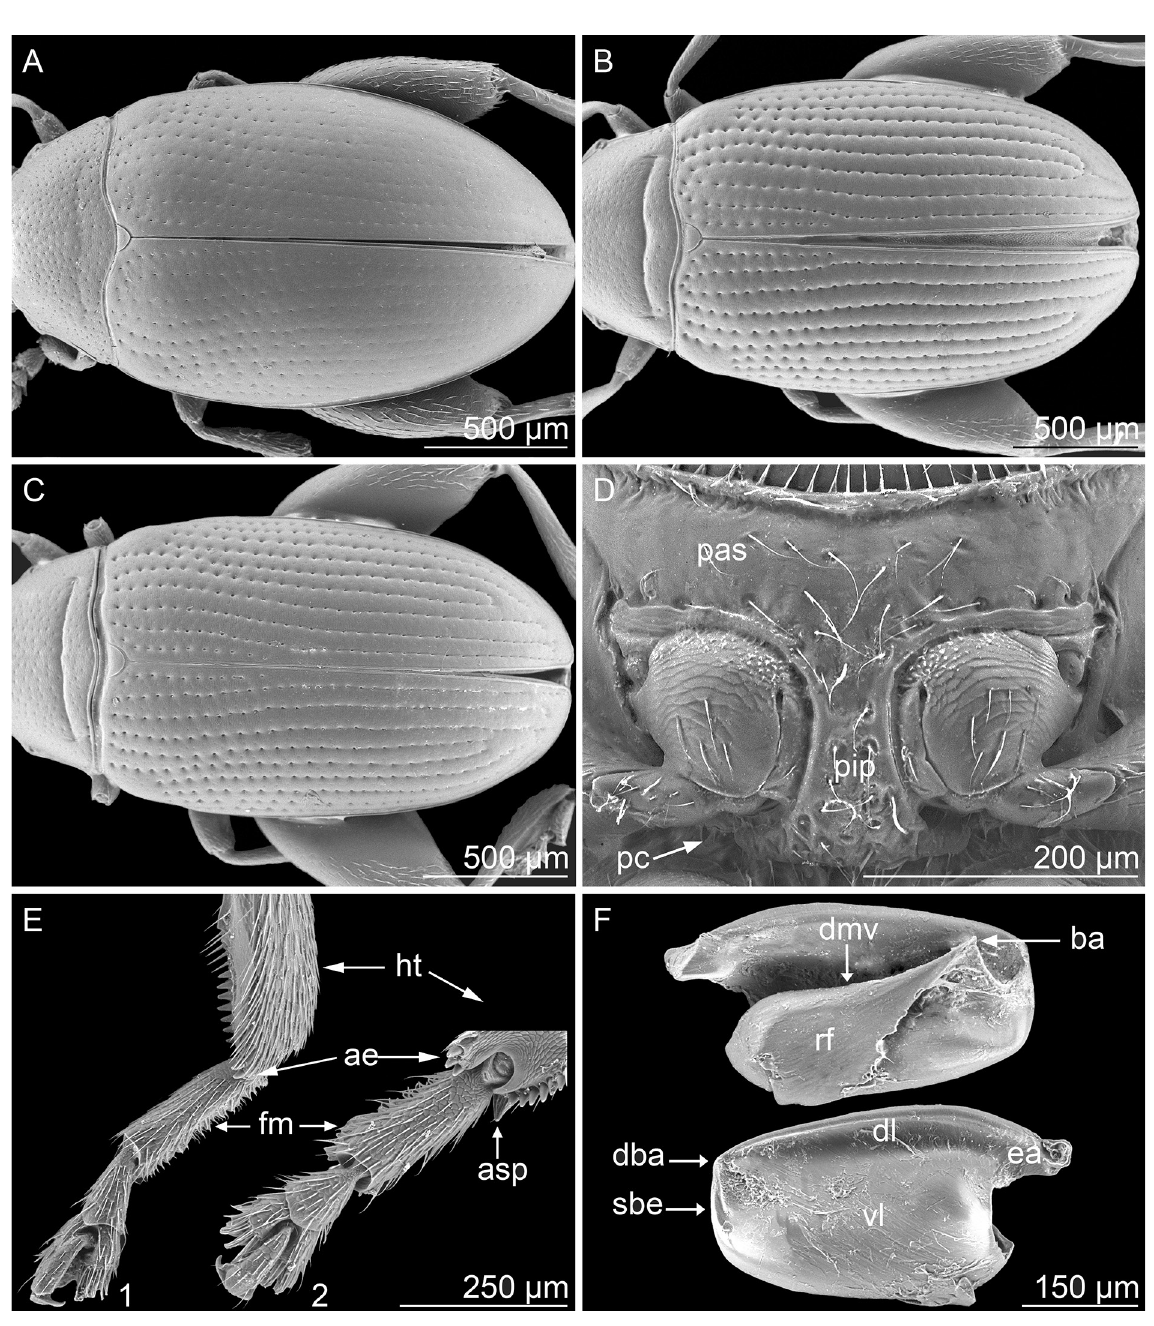
Fig. 6. A–C . Elytra. A . Arsipoda atra sp. nov., Aoupinié. B . A. geographica Gómez-Zurita, 2010, Dzumac Mts (base). C . A. shirleyae Samuelson, 1973, Chute de la Madeleine. D . Prosternum of A. punctata sp. nov. , Mueo. E . Hind tibia and tarsus of A. communis sp. nov., Dzumac Mts (1) and A. shirleyae Samuelson, 1973, Pic du Pin (2). F . Metafemoral spring of A. communis sp. nov., Dzumac Mts. Abbreviations: ae = apical emargination with thickset spines; asp = apical spur of hind tibia; ba = basal angle of ventral lobe; dba = dorsal-basal angle of metafemoral spring; dl = dorsal lobe; dmv = dorsal margin of ventral lobe; ea = extended arm of dorsal lobe; fm = first metatarsomere; ht = hind tibia; pas = prosternal antecoxal space; pc = procoxal cavities posteriorly open (arrows); pip = prosternal intercoxal process; rf = recurve flange; sbe = spring basal edge; vl = ventral